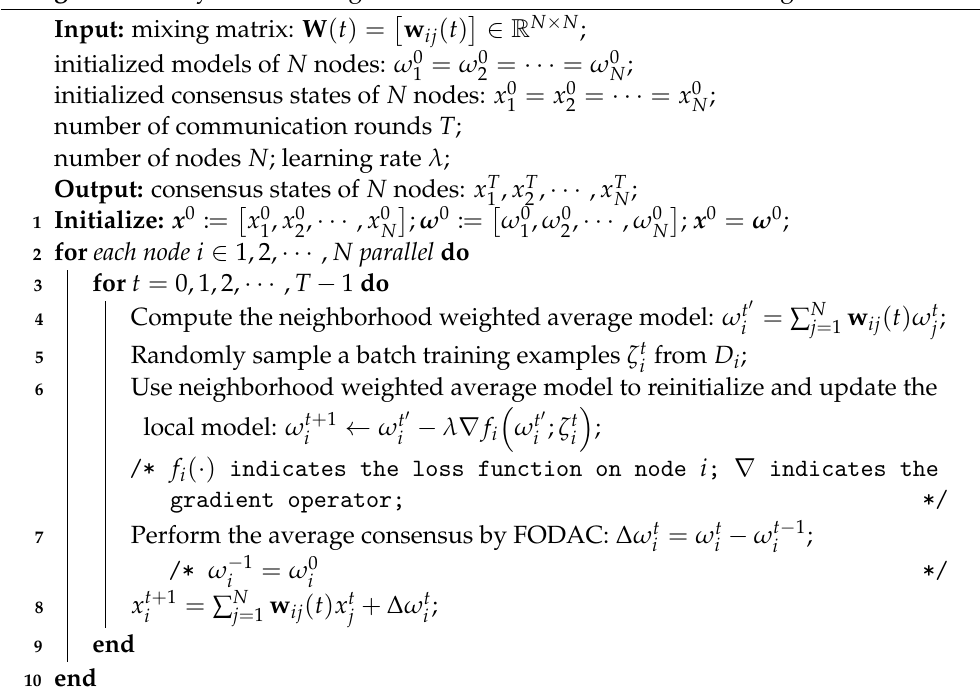
Algorithm 2: Dynamic Average Consensus-based Federated